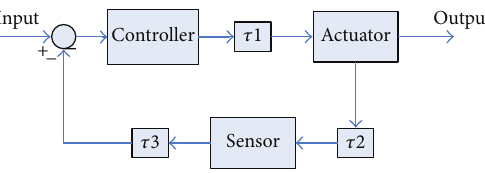
Figure 2: A control process with various time